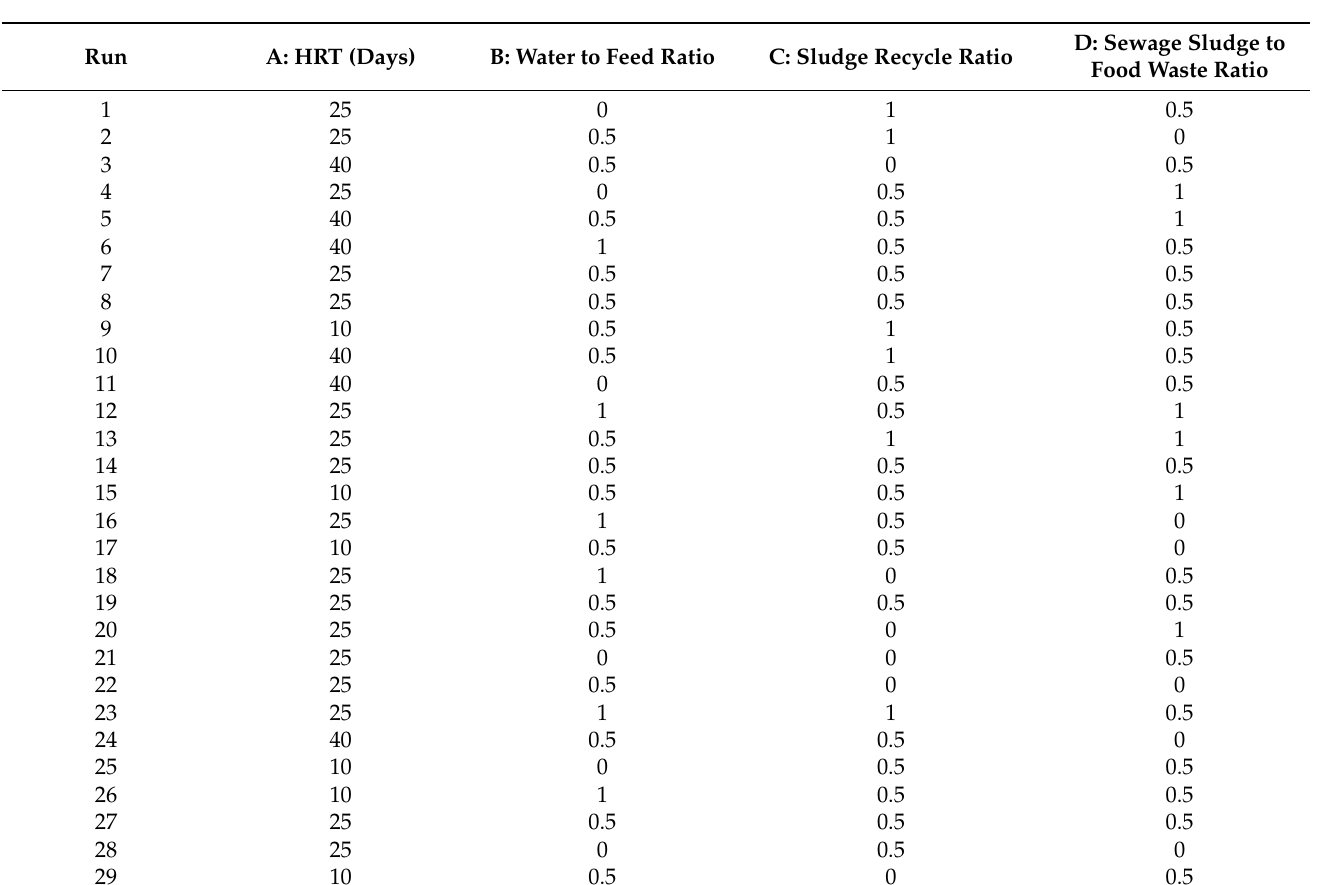
Table A3. Box–Behnken design